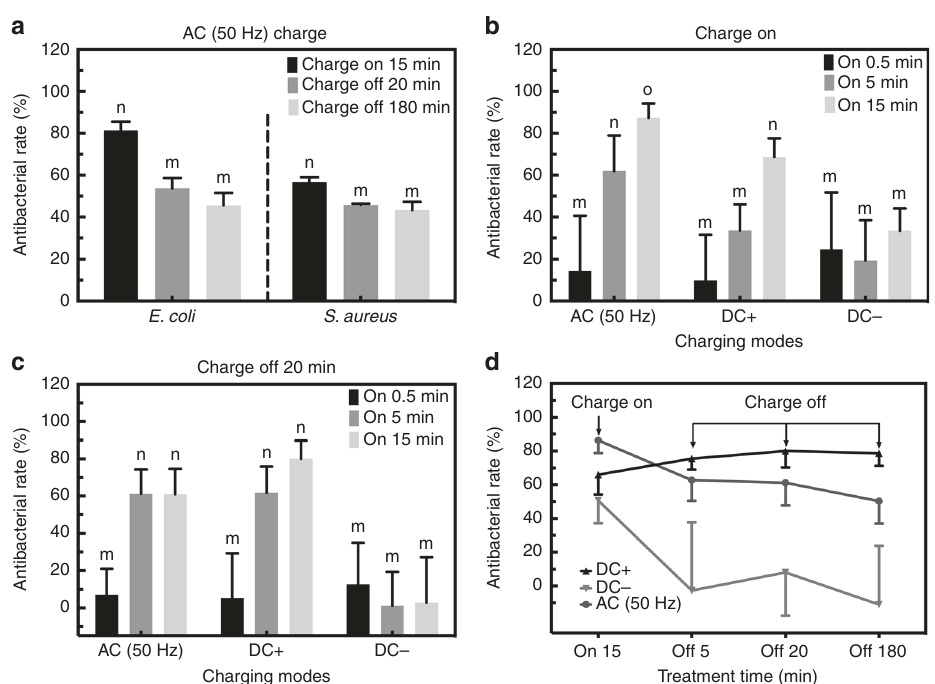
Fig. 4 Antibacterial effects in different charging modes. a Antibacterial effect on E. coli and S. aureus triggered by AC. b On-charging antibacterial effects of TNT-C-15 on E. coli during the charging process. c Post-charging antibacterial effects of TNT-C-15 on E. coli after charging for different time. d Overall antibacterial curves of TNT-C-15 on E. coli triggered by AC, DC + and DC – . All error bars = s.d. ( n = 3). Signi fi cant differences between groups are marked by different letters (m – o, P < 0.05, SNK test in